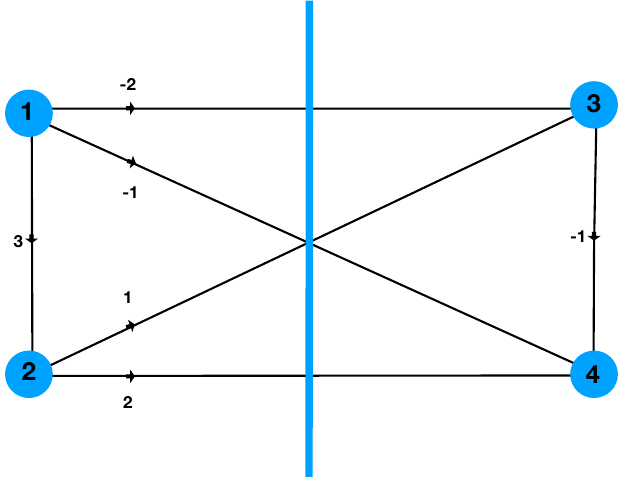
Figure 1. A string configuration for the bipartition of 4